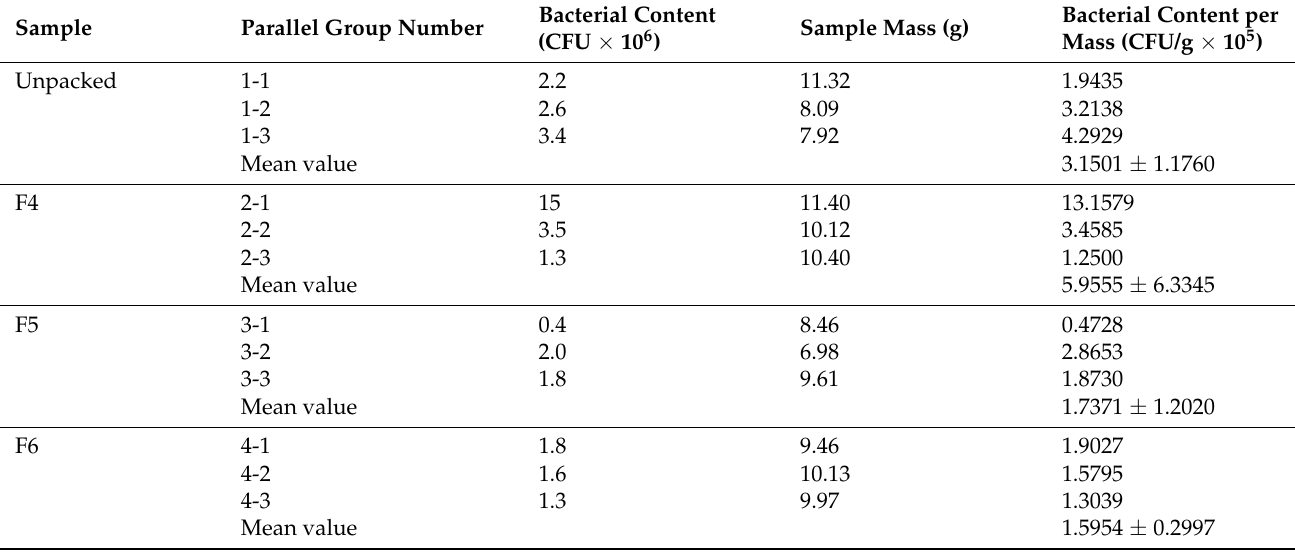
Table 2. Bacterial test parameters of cherry tomatoes after 12th